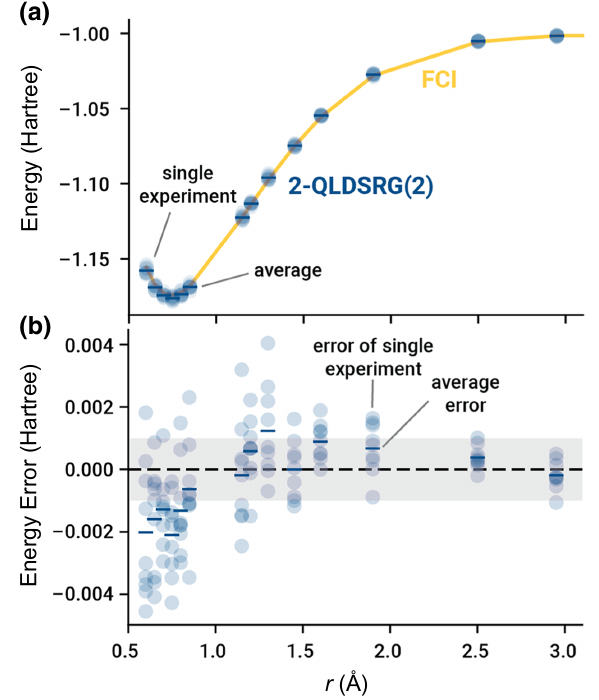
FIG. 4. (a) The dissociation curve and (b) the energy error for the H 2 molecule computed with the 2-QLDSRG(2) using one qubit on the IBM_LAGOS device. The energy errors are with respect to FCI energies. For each geometry, the semiopaque blue circles aligned vertically show the distribution of energies (energy errors) from nine experiments, with each experiment consisting of 32 000 measurements, while the horizontal bars in blue denote average energies or average energy errors. All computations use the cc-pV5Z basis [85] (110 basis functions), CASSCF(2,2) orbitals, and the flow parameter value s = 0.5 E − 2 The gray-shaded area indicates unsigned energy errors below 1 m E h . The unsigned energy errors and the standard deviations are reported in Table